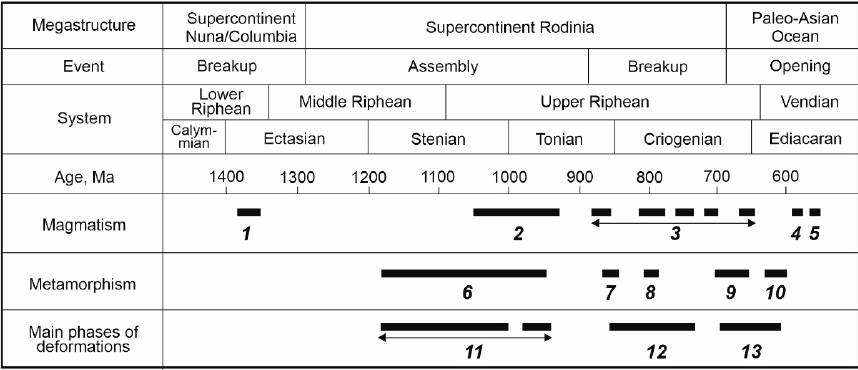
Figure 38. Sequence of magmatic, metamorphic, and deformation events throughout the Transangarian Yenisey Ridge during Precambrian time. 1: rift-related plagiogneisses of Nemtikha Group; 2: Teya-type granite gneisses and metapicrite–basalt sequence of Angara region; 3: postcollisional, within-plate and rift-related granitoid plutons with contact metamorphic aureoles and alkaline rocks; 4: mafic metavolcanites (amygdaloidal basalts) of the Kiselikha Group; 5: leucogranites of the Osinovka massif; 6: regional low-pressure andalusite-sillimanite metamorphism; 7: collision-related medium-pressure kyanite-sillimanite metamorphism caused by westerly directed overthrusts; 8: medium-pressure collisional metamorphism caused by easterly directed overthrusts; 9: blueschist facies metamorphism associated with subduction zones; 10: dynamic metamorphism in shear zones; main folding phases during 11: the Grenville orogeny, 12: the Valhalla orogeny, and 13: the Baikal orogeny.